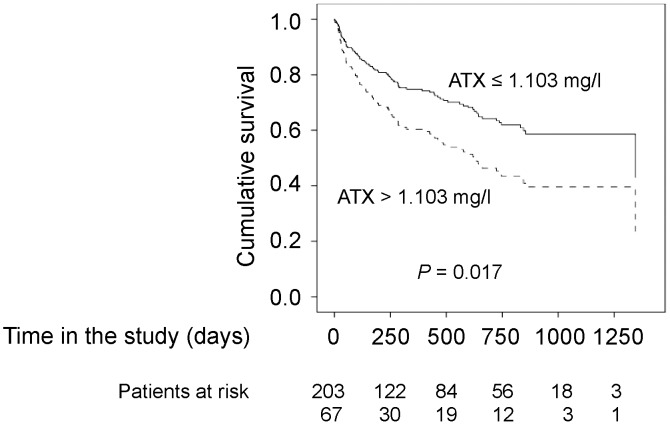
Low serum ATX levels are associated with longer survival.Survival plots show the cumulative survival of patients with high or low autotaxin serum levels. The cumulative survival was calculated with a univariate Cox regression model.